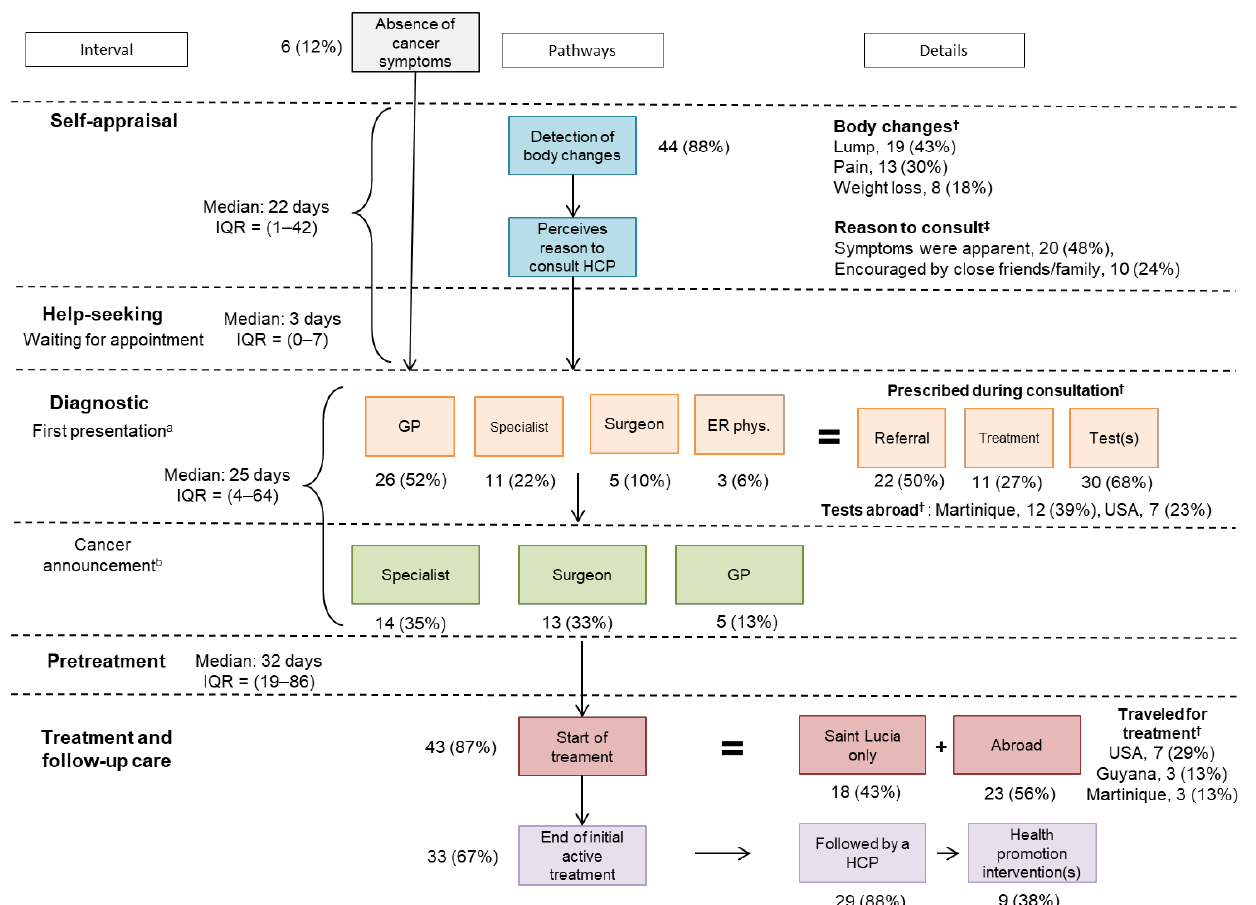
Figure 2. Summary of pathways to diagnosis and treatment of Saint Lucian cancer survivors with time intervals. Saint Lucia